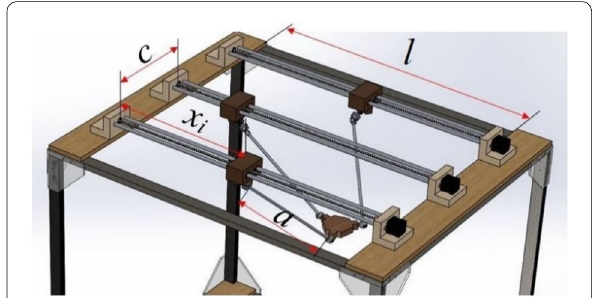
Figure 1 CAD model of the 3-PRUS manipulator